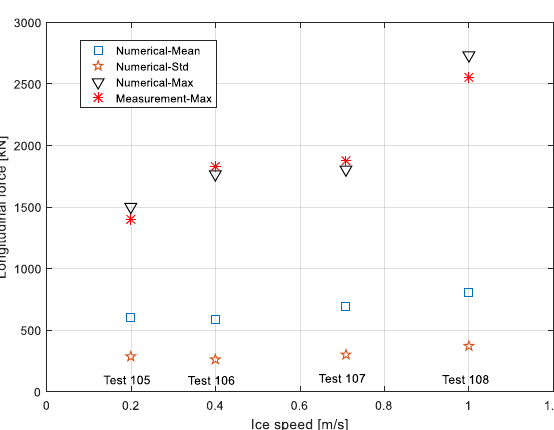
Figure 10. Numerical and measured ice force as a factor of ice speed.